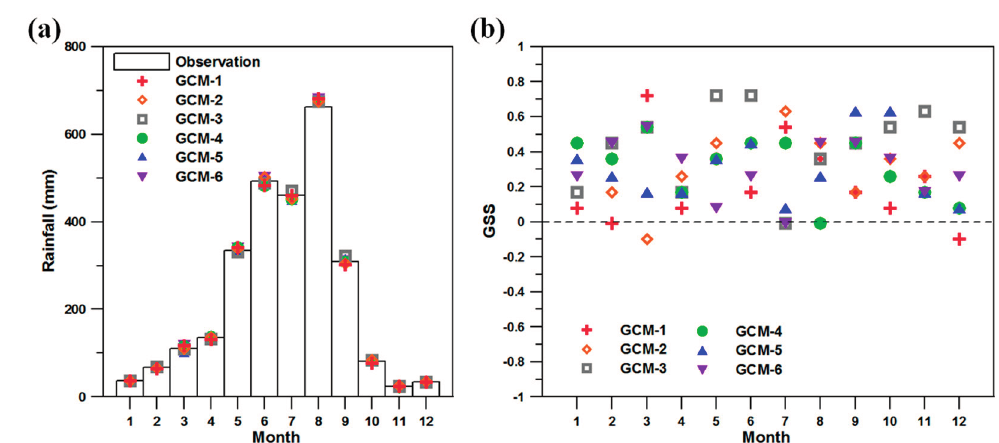
Figure 3. ( a ) Observation and scenario data during the period between 1975 and 2000 and ( b ) the Gerrity skill scores of each GCM.